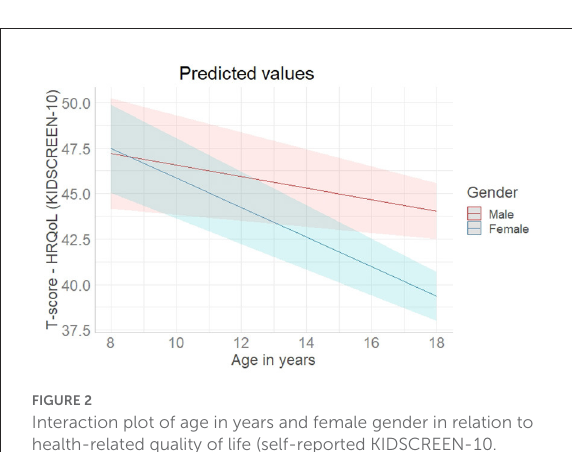
FIGURE2 Interaction plot of age in years and female gender in relation to health-related quality of life (self-reported KIDSCREEN-10. Adjusted for school type and sum of epidemic-related Dark Future Scale for children (eDFS-K) (see Table 4, Multivariable Model 2). The colored lines and the colored areas represent the estimated effects and the 95% confidence